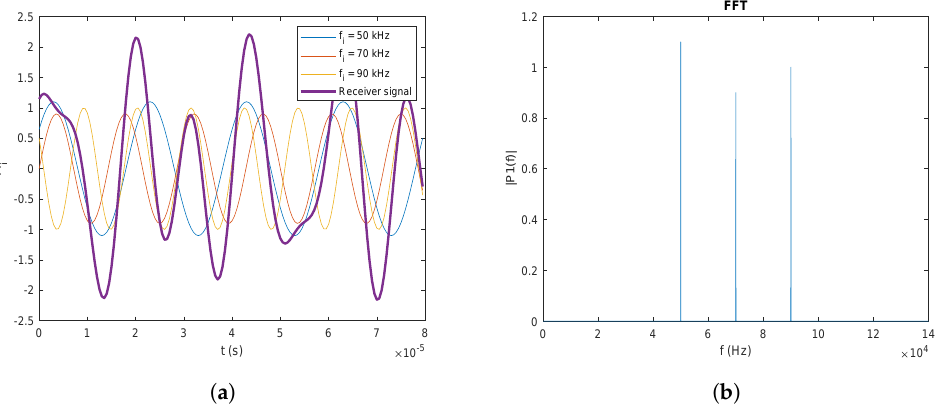
Figure 3. Example of three emitters using FDMA: ( a ) in the time domain; and ( b ) in the frequency